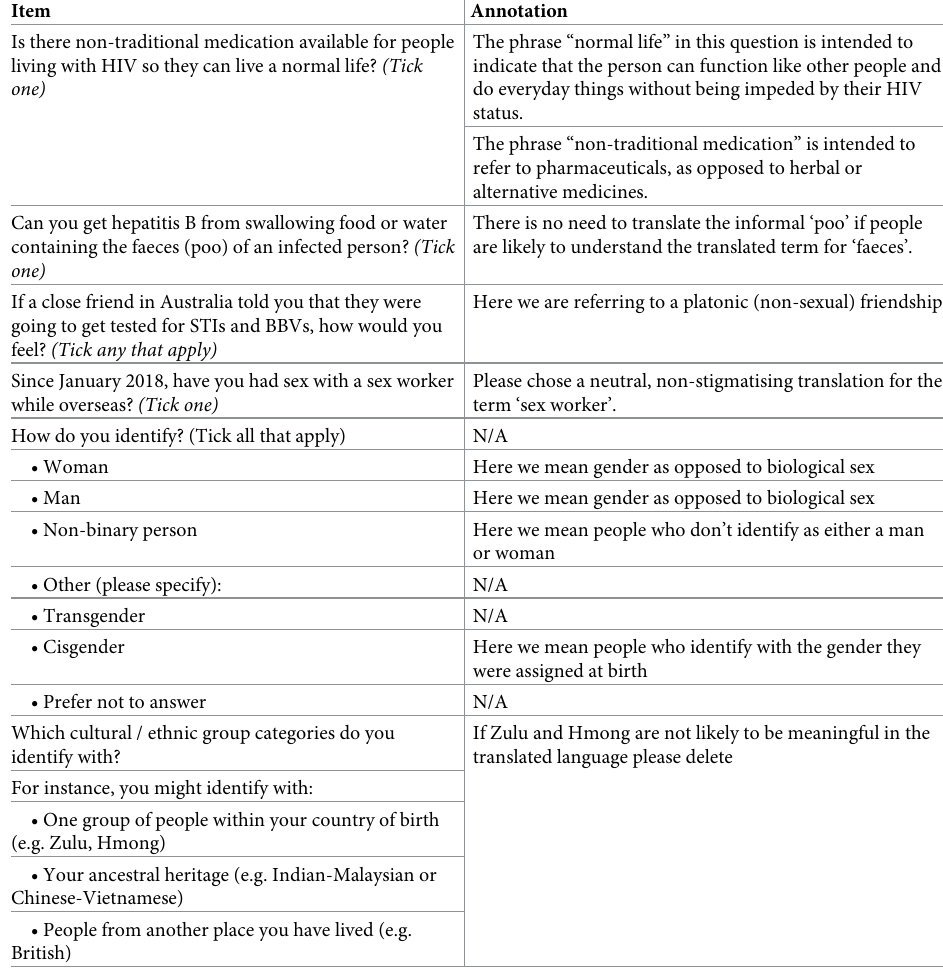
Table 1. Example of information provided to